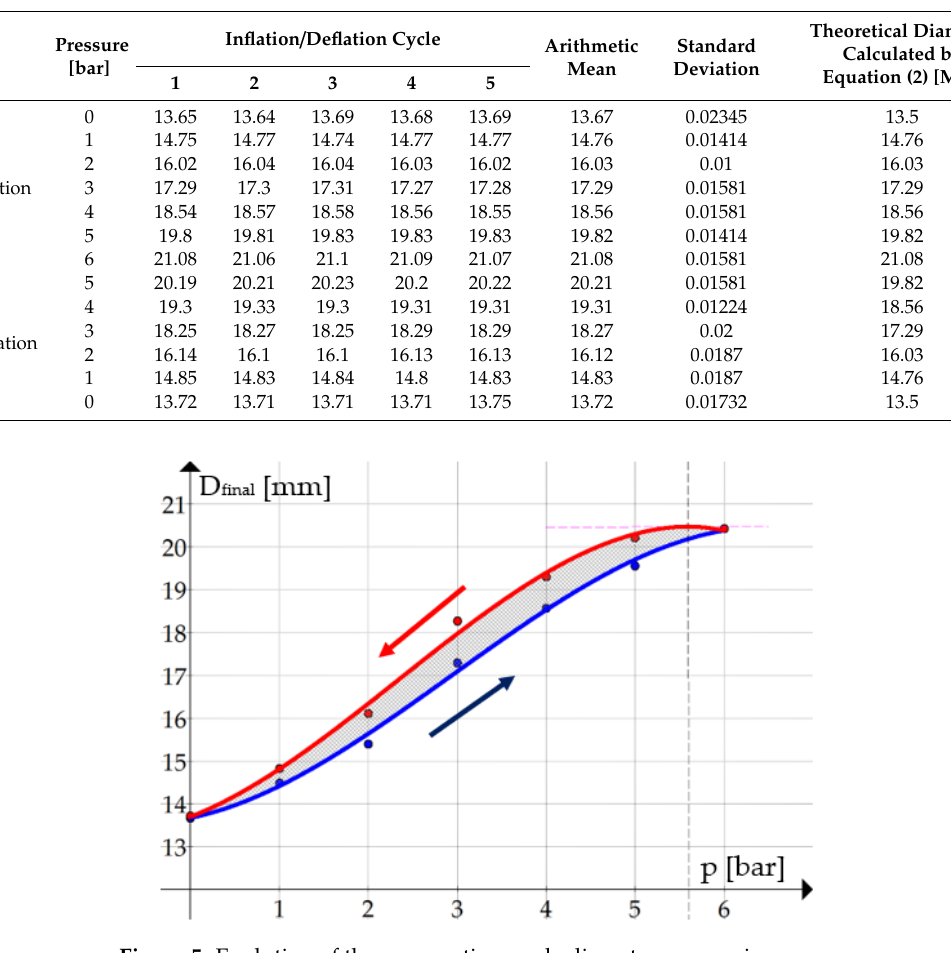
Figure 5. Evolution of the pneumatic muscle diameter versus air pressure.